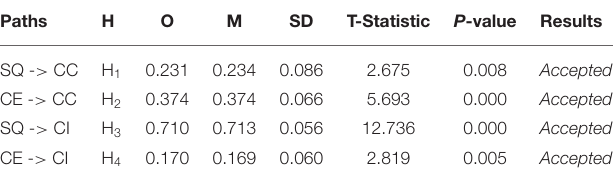
TABLE 5 | The direct effects of the variable. Paths